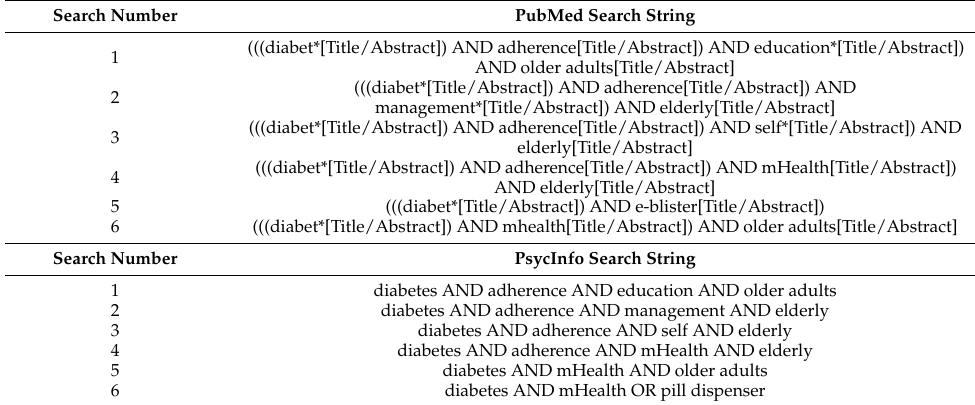
Table 1. Search terms used in PubMed and